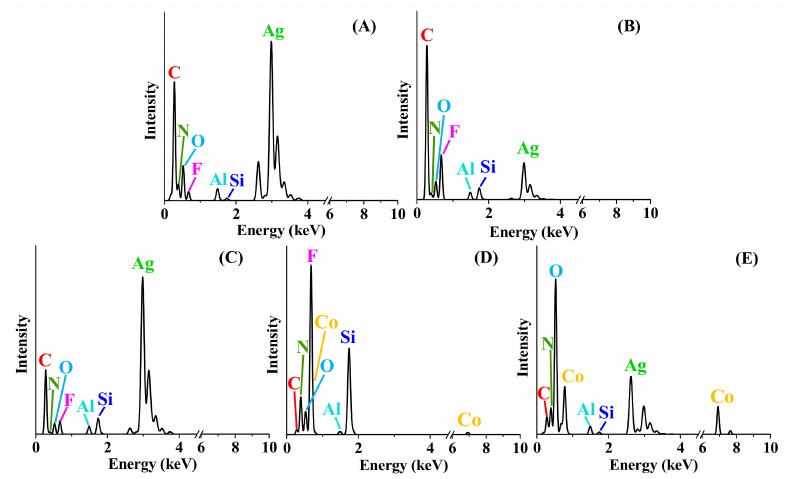
Figure 7. EDS spectrum of the particles in aqueous wastes, where ( A ), ( B ), ( C ), ( D ) and ( E ) represent S#1, S#2, S#3, S#4 and S#5, respectively.